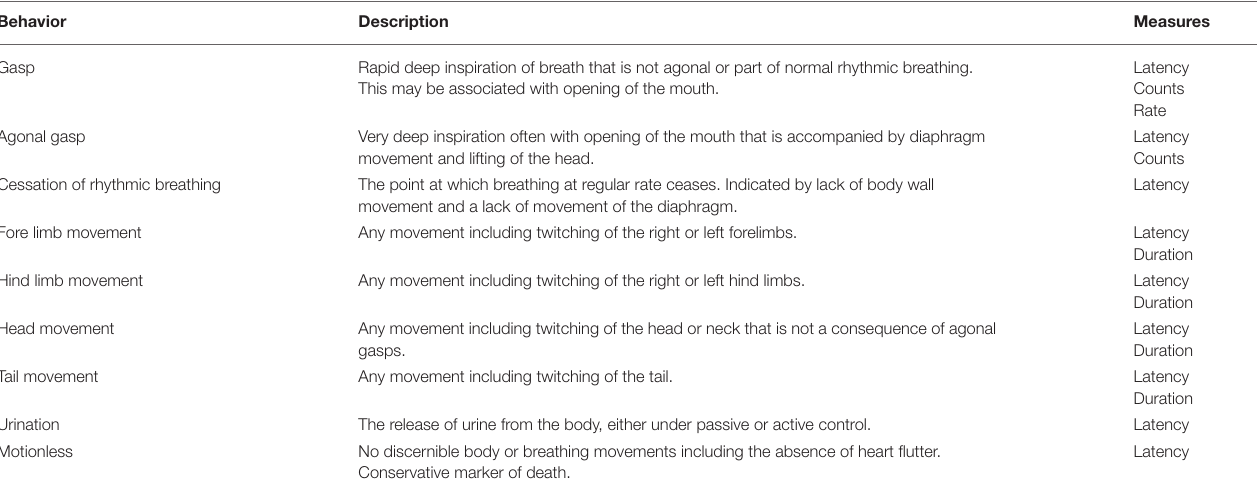
TABLE 1 | Ethogram showing behavioral latencies, counts, durations and rates recorded. Behavior